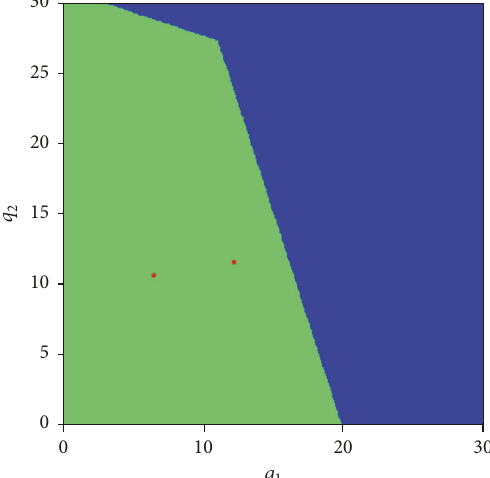
Figure 28: Basins of attraction, 𝛼 = 0.3 , 𝛽 = 0.1 , and 𝑞 3 = 5 .